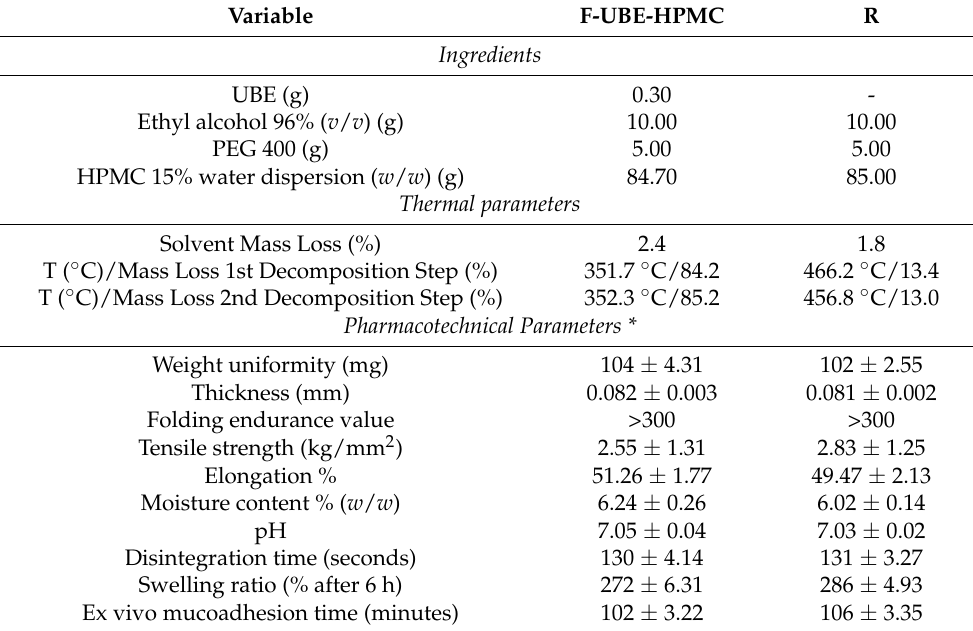
Table 1. Composition and properties of mucoadhesive oral patches loaded with U. barbata dry extract in 96% ethanol (F-UBE-HPMC) versus References